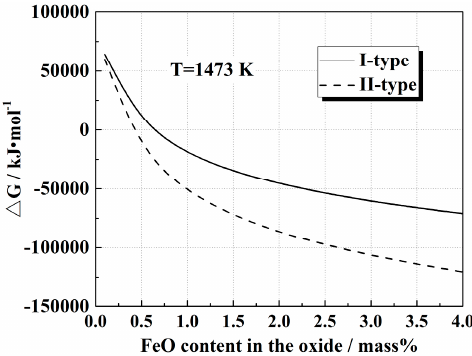
Figure 13. Effect of the original FeO content in the oxide on the Gibbs energy change of the I-type and II-type reactions during heat treatment at 1473 K.